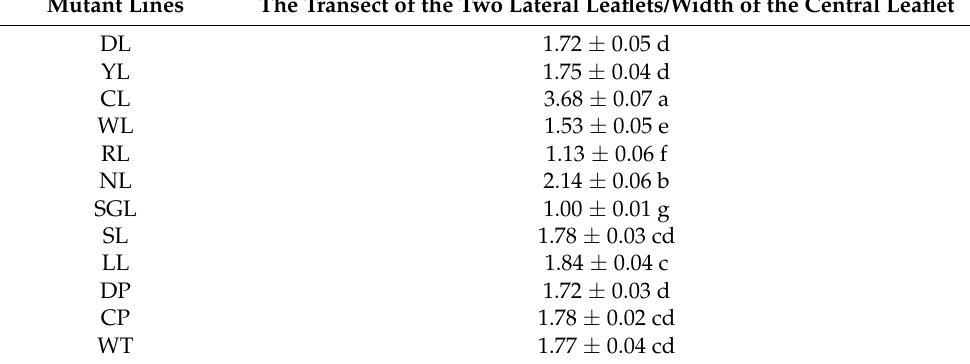
Table 3. Statistics on the transect of the two lateral leaflets/width of the central leaflet in 11 mutants of F. nilgerrensis . Mutant Lines The Transect of the Two Lateral Leaflets/Width of the Central